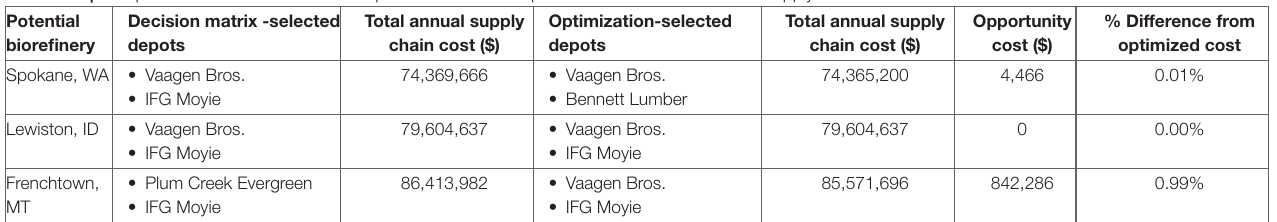
TABLE 10 | Comparison of decision matrix and optimization model depot selections and total annual supply chain cost. Potential